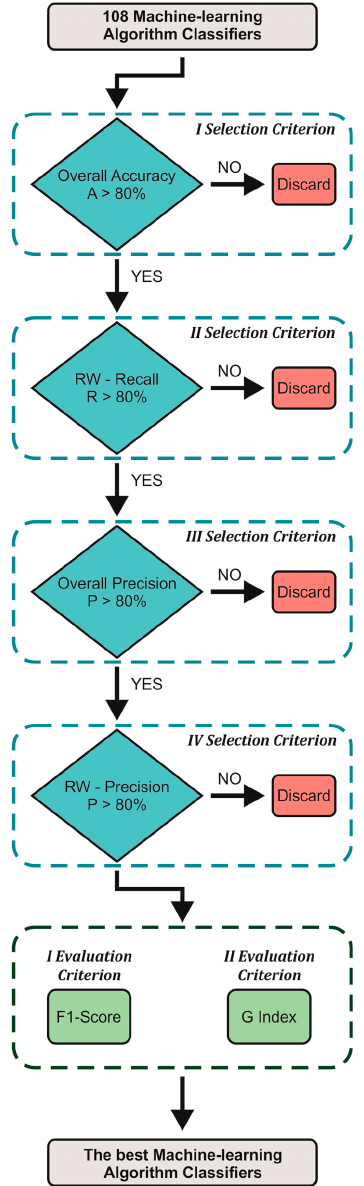
Figure 6. Flow chart for the identification of the best-performing classifiers. RW stands for race walking condition.